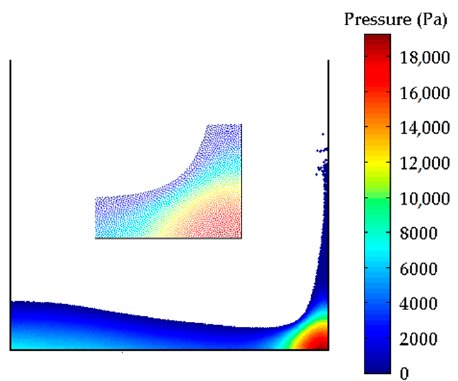
Figure 12. Pressure field in the smoothed particle hydrodynamics (SPH simulation) ( h = 1.33 ∆ x , ∆ x = 0.0125 m, t = 0.9 s )